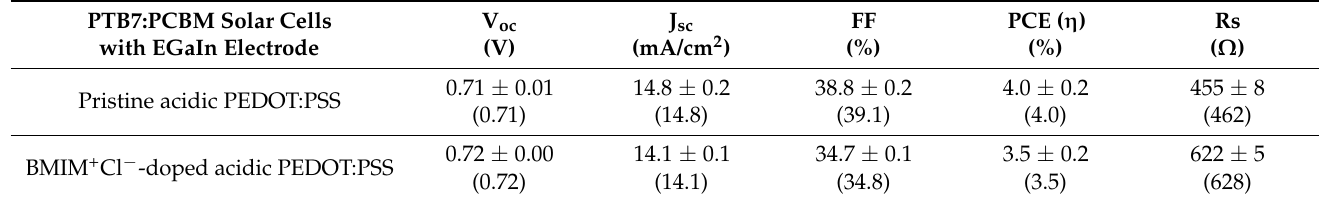
Table 2. Photovoltaic parameters of PTB7:PCBM solar cells with BMIM + Cl − -doped acidic PEDOT:PSS as hole-transport layers used with liquid EGaIn electrode.